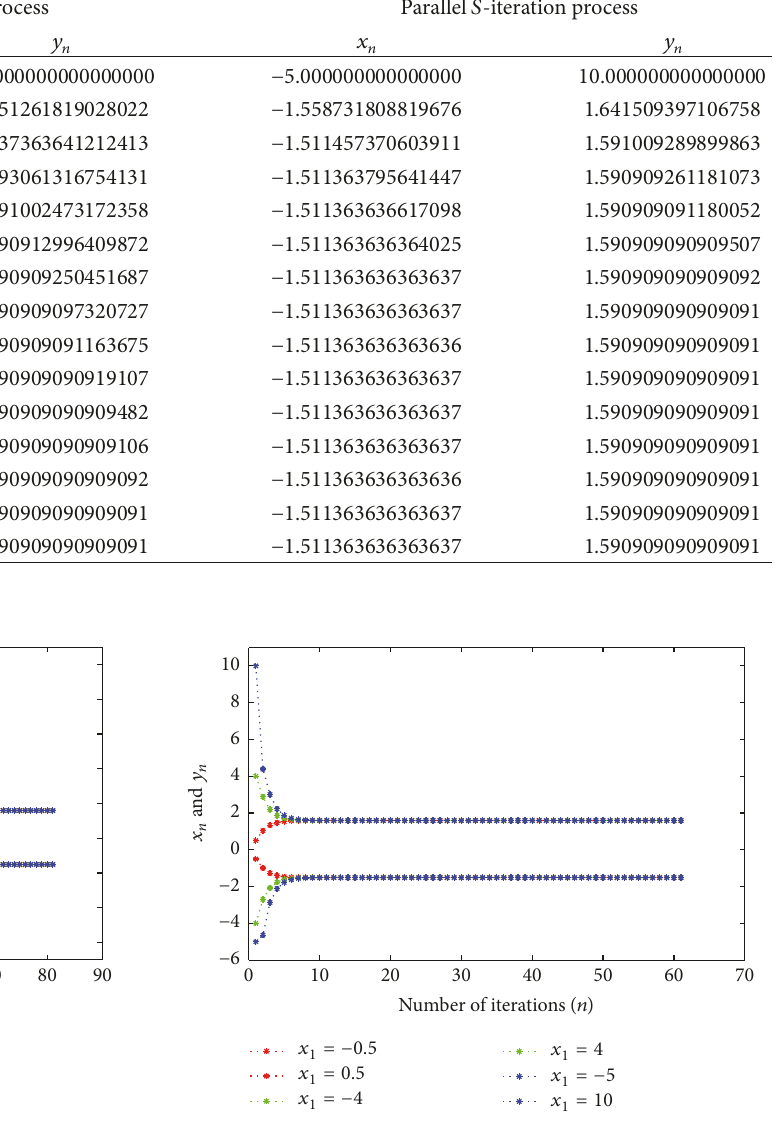
Figure 2: Convergence of sequences {𝑥 𝑛 } and {𝑦 𝑛 } generated by parallel 𝑆 -iteration process